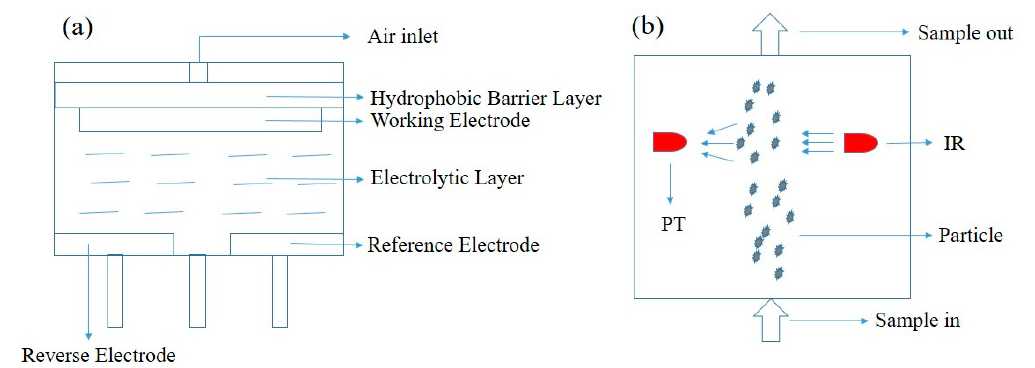
Figure 2. Schematic diagrams of the sensors evaluated in this work: ( a ) CO and O 3 , and ( b ) PM 2.5 . PT: Photodetector